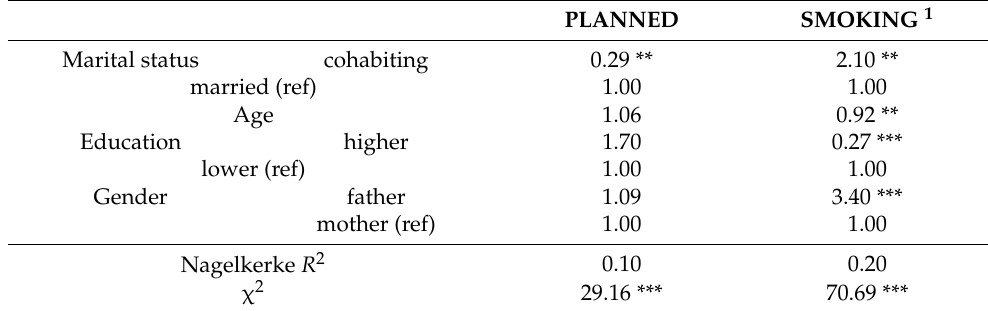
Table 4. Results from logistic regressions predicting Baby PLANNED for and SMOKING.